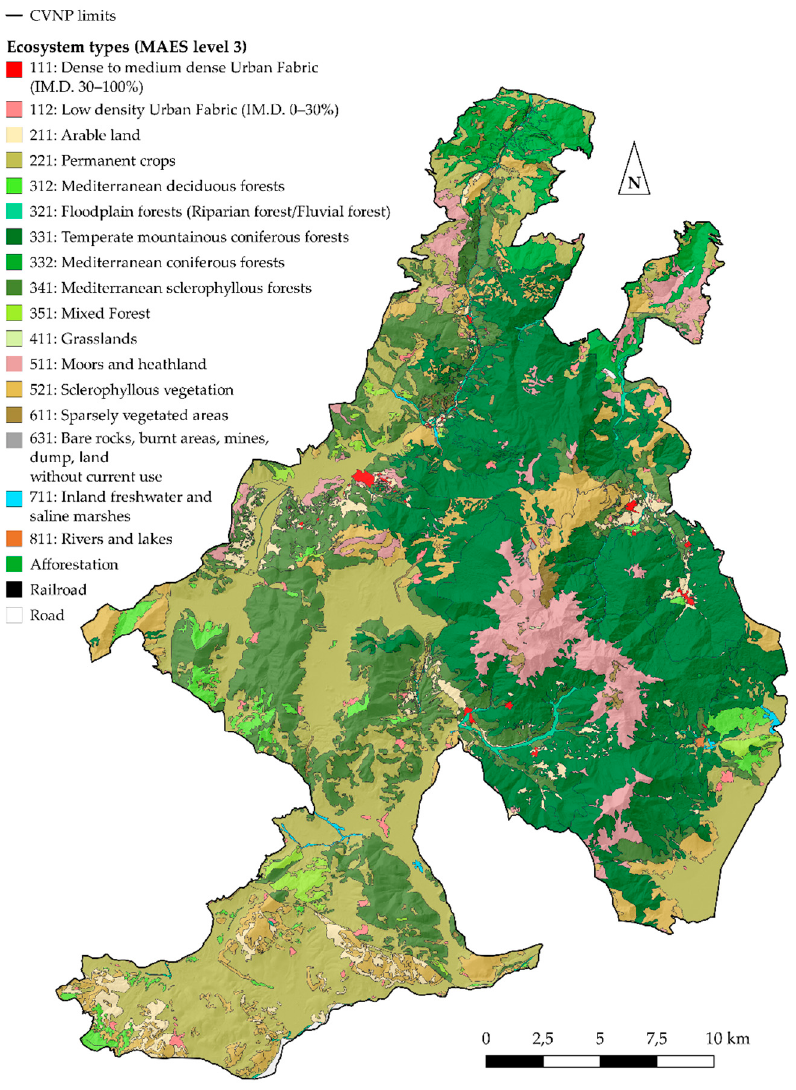
Figure 6. Ecosystem types (MAES level 3 [17,37] map of the CVNP. The distribution of different MAES level 3 ecosystem types revealed that diversity hotspots are present at the surrounding area of Kalavrita city and along the Vouraikos river gorge (mainly at its southern parts); secondary hotspots are found scattered throughout the area (Figure 7).